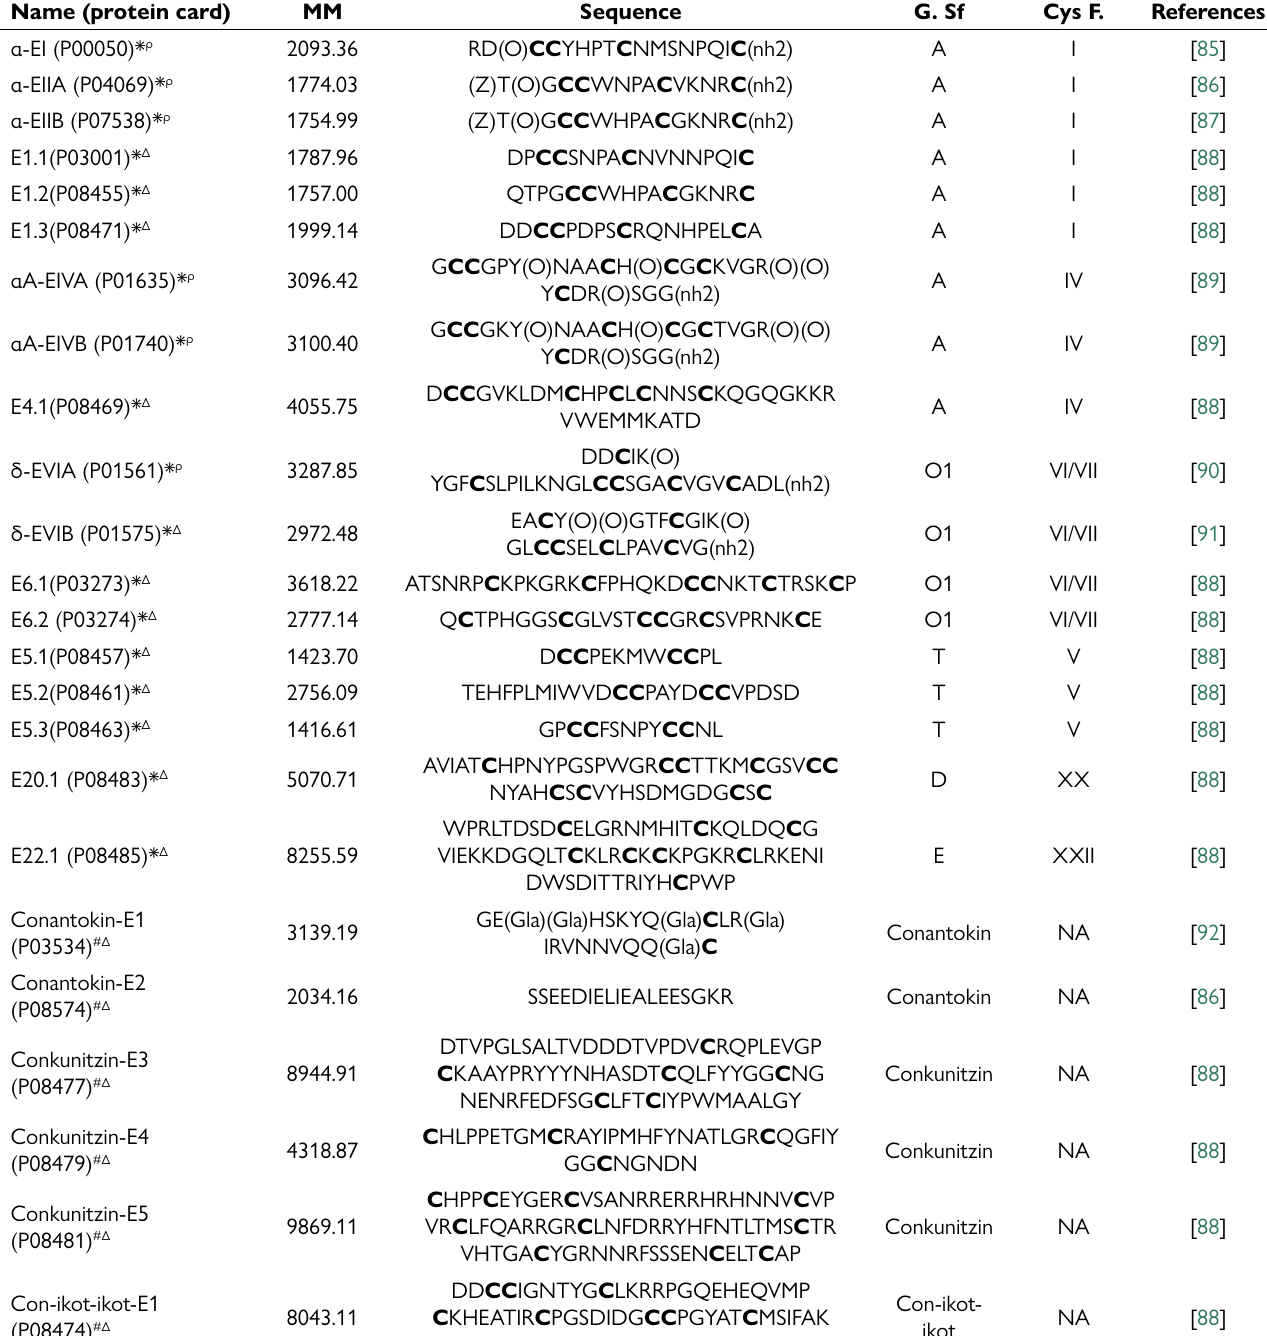
Table 7. Conopeptides identified in the venom of Conus ermineus .